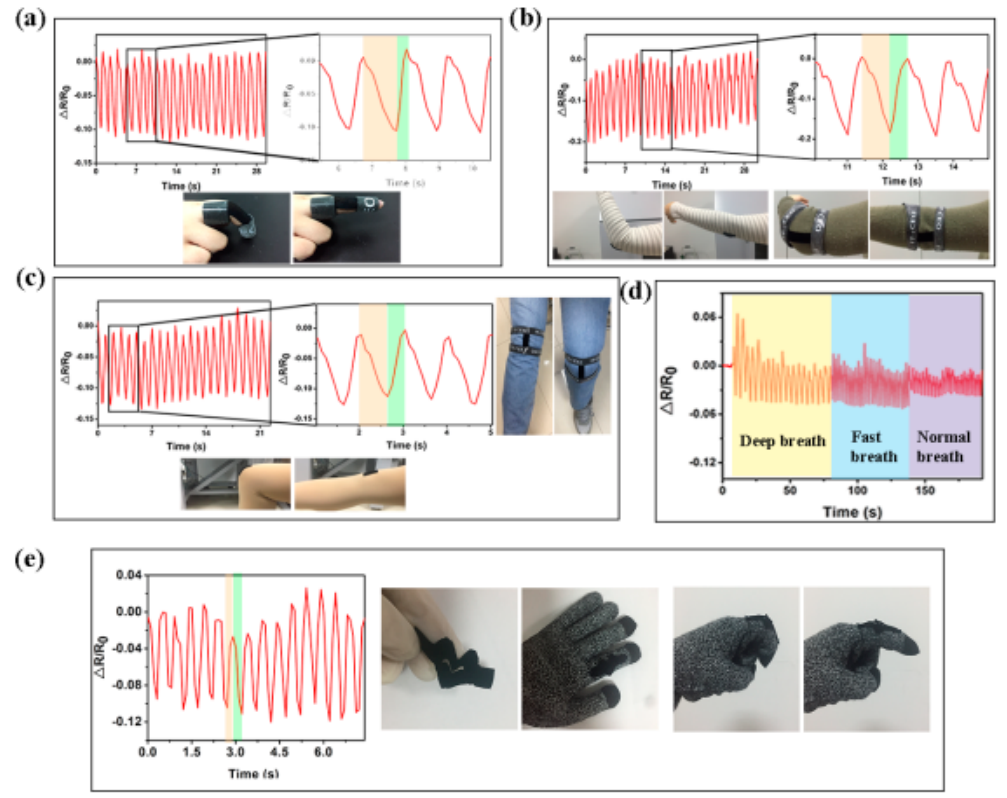
Figure 7. Responses of the textile-based strain sensors to human finger bending ( a ), elbow bending ( b ) and knee bending ( c ). Inserts are the photos showing the attachment of the devices on human body. ( d ) Real-time measurements of respiration by fixing a sensor on the volunteer’s abdomen. ( e ) Real-time measurements of finger bending by a glove-stitched sensor.